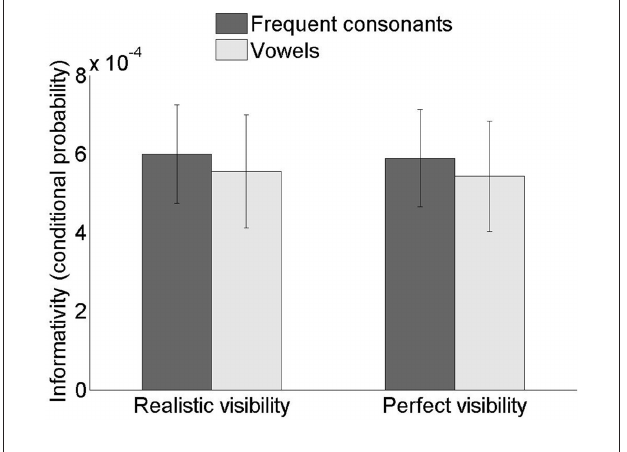
Figure 3 | conditional probabilities of the frequent consonant and vowel stimuli used in Duñabeitia and carreiras (2011) calculated using the method described by Stevens and grainger (2003) for individual position-coded